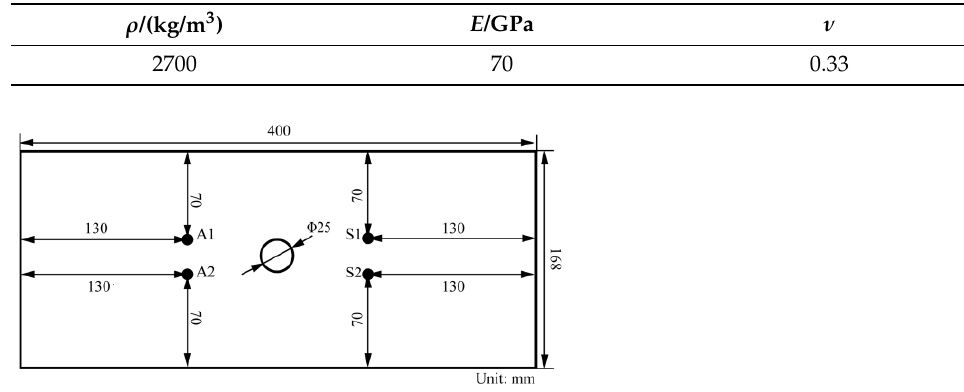
Figure 3. Specimen geometry and PZT sensors placement.